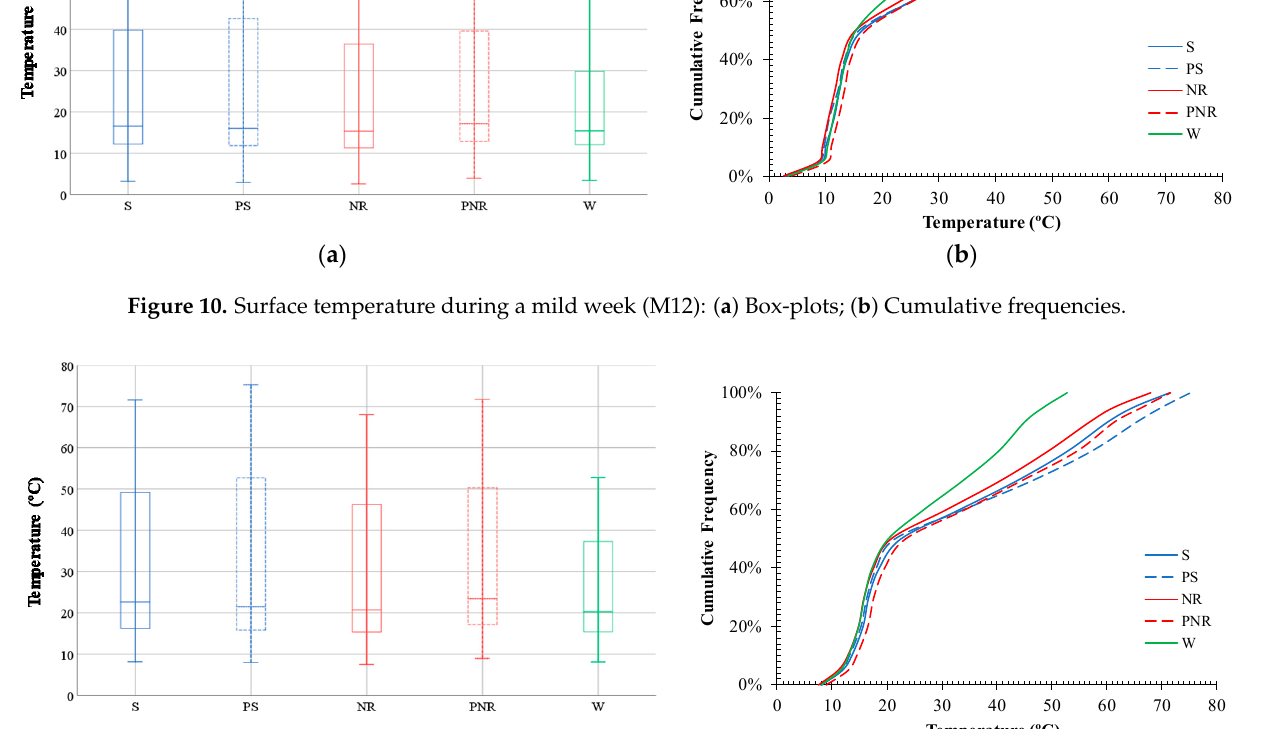
Figure 11. Surface temperature during a hot week (M13): ( a ) Box-plots; ( b ) Cumulative frequencies.